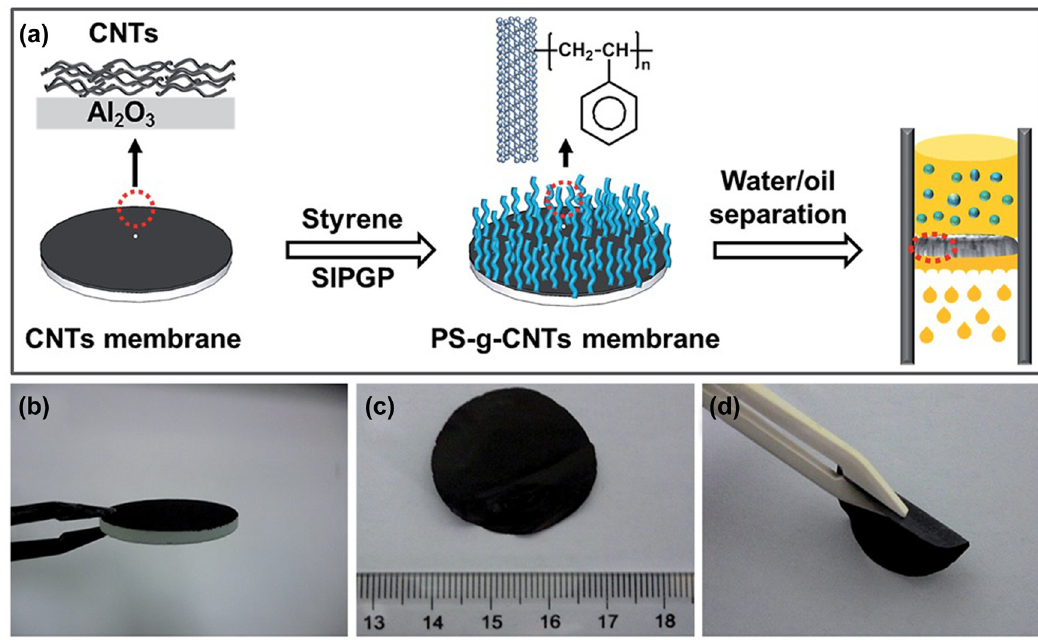
Figure 15: ( a ) Fabrication scheme of PS/CNT membrane. Photographs of ( b ) composite on Al 2 O 3 membrane substrate, and ( c and d ) free - standing durable PS/CNT composite membrane after etching Al 2 O 3 [ 163 ] . Reproduced with permission from ref. [ 163 ] ; © 2014 The Royal Society of Chemistry.